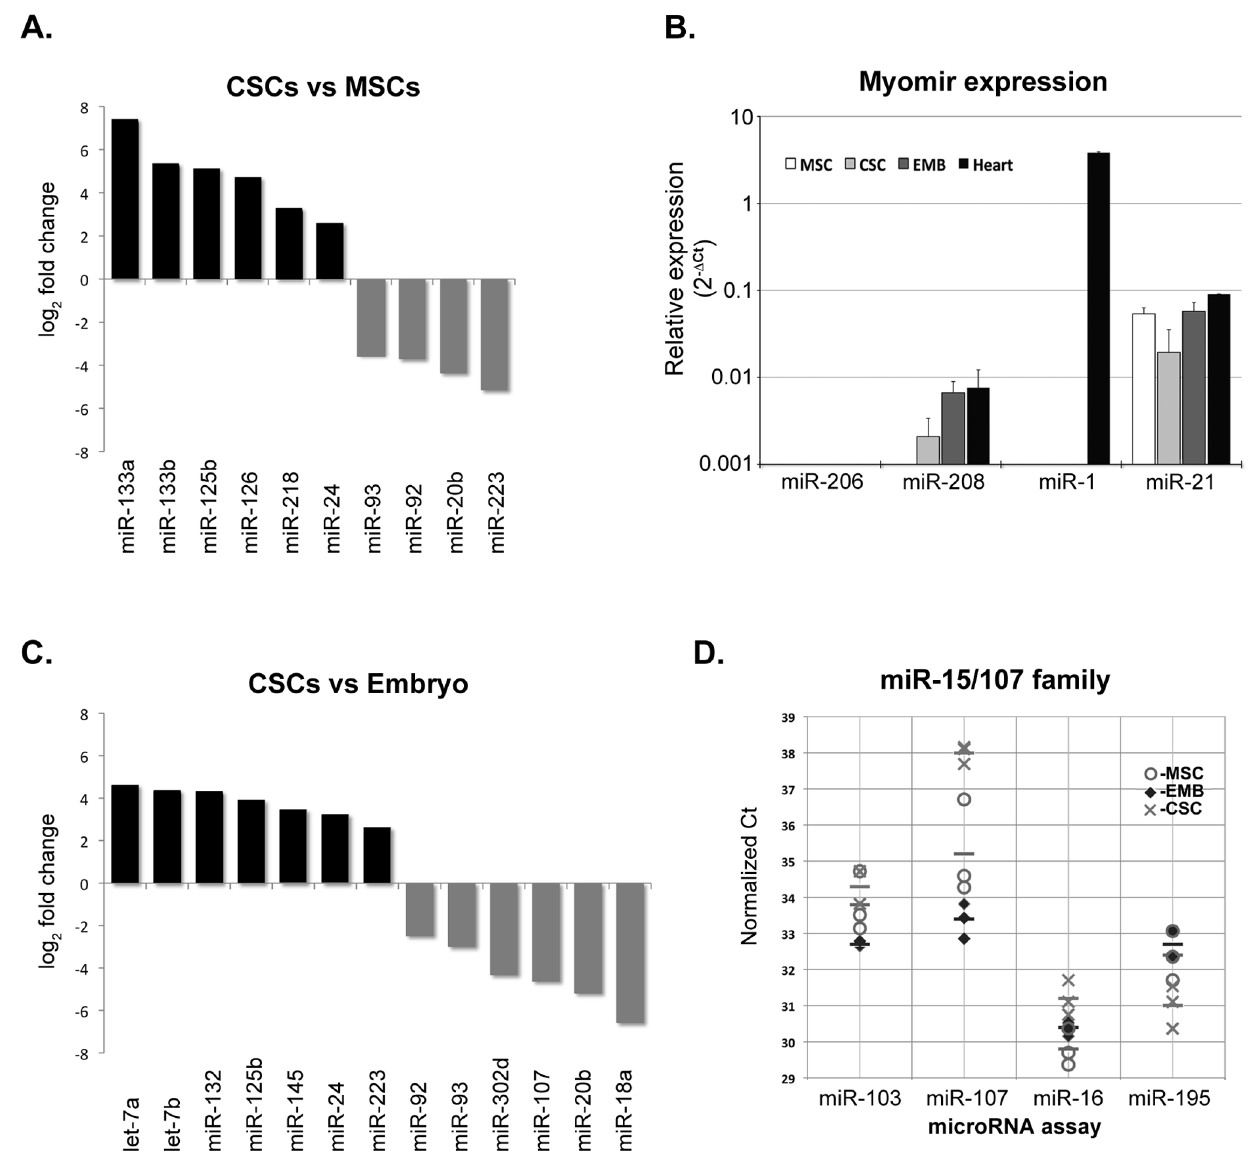
Figure 2. Differential expression analysis of microRNAs. A. Differentially expressed miRs in adult cardiac and immature bone marrow stem cell populations (CSCs and BMCs) . Average log2 expression ratio of all differentially expressed miRs (p , 0.01). B. Comparison of expression of muscle specific miRs in embryonic heart cells (EMB), BMCs and CSCs, and mouse heart tissue using Taqman probes (n=3). Data shows relative expression (2 2 D Ct ) normalized to sno202 RNA expression levels. C. Differentially expressed miRs in adult cardiac versus embryonic mouse heart cells. Average log2 expression ratio of all differentially expressed miRs (p , 0.01). D. miR-15/107 family expression levels in the cell populations characterized in this study. Plot displays normalized Ct values for each independent biological replicate sample of miR-15/107 family members present in the qPCR array. miR-107 is specifically downregulated in CSCs. Horizontal bar marks average Ct.